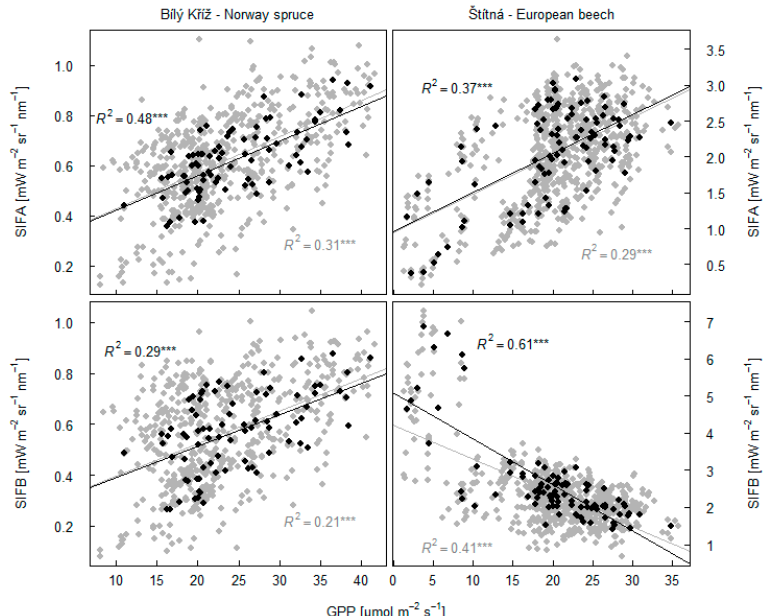
Figure 11. Dependency between SIFA and GPP at examined forest sites is shown in the upper panels. Dependency between SIFB and GPP is shown in the bottom panels. Black points refer to seasonal values of parameters averaged across 2 h long intervals on days with clear sky conditions. Grey points show relationship between data on selected days in 30 min temporal intervals between 10:00 and 14:00 h. The asterisk *** indicates statistically significant result at p < 0.001.